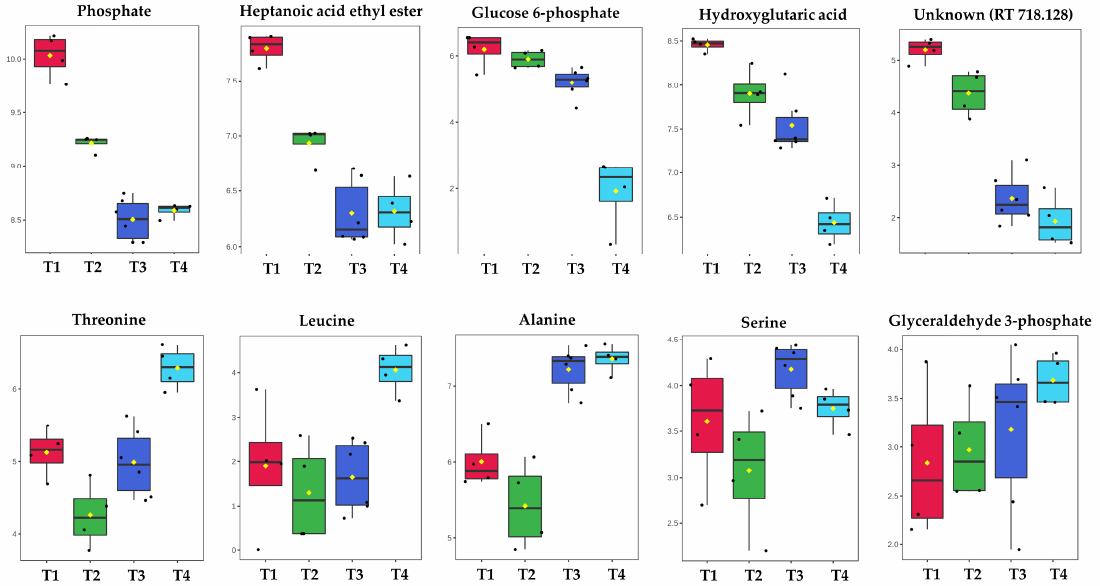
Figure 3. Relative peak areas of the significant metabolites identified by PCA of the GC-MS data acquired from the samples analyzed within the Manchester laboratories. Di ff erent colors indicate the various timepoints, T1 (22 h, red), T2 (23.5 h, green), T3 (28 h, blue), and T4 (35 h, cyan).